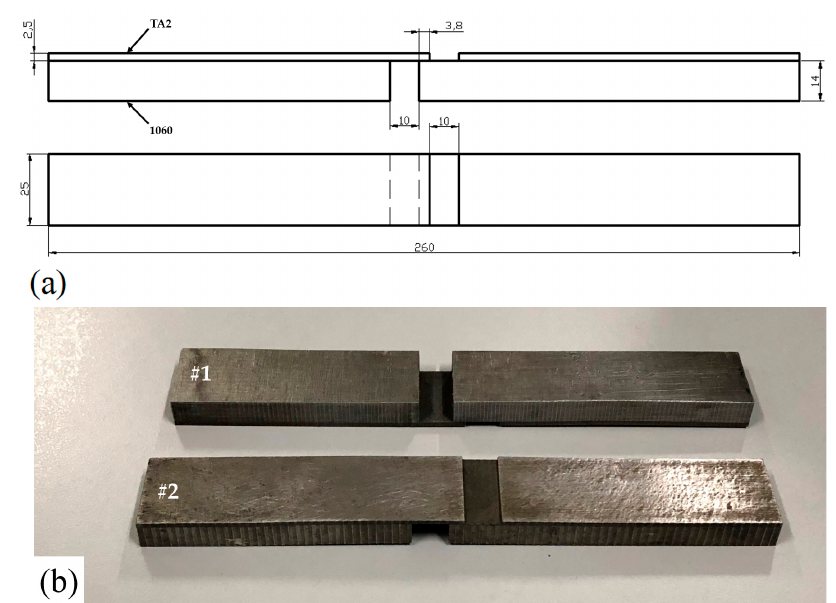
Figure 9. Tensile shear test of sample 1 and sample 2: ( a ) schematic diagram of tensile shear sample (unit: mm); ( b ) tensile shear samples of sample 1 and sample 2.